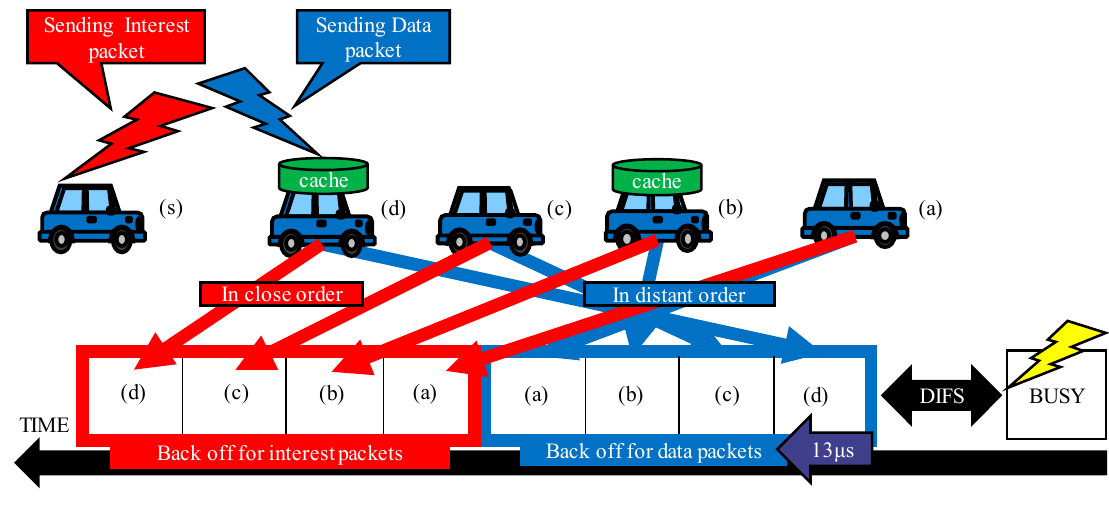
Figure 4. ECV method.